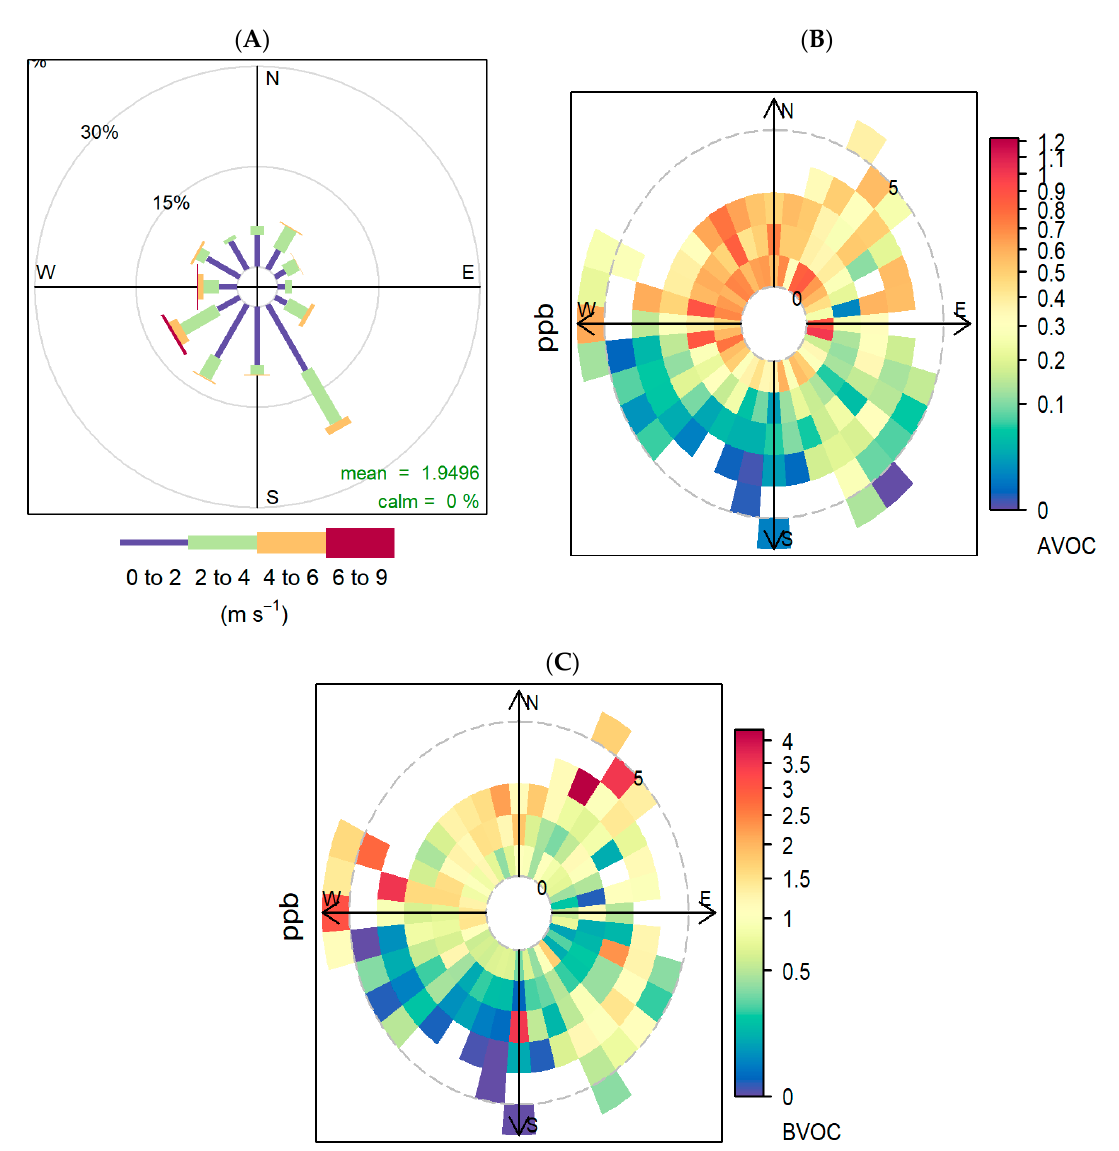
Figure 6. ( A ) Wind rose using wind observations at 10-m height for the entire sampling period. Predominance of the SW direction can be observed, with more than 35% of the observations coming from that quadrant, followed by SE winds with 25% of frequency. In addition, 85% of the time, the wind speed was lower than 3 m/s. ( B ) Polar plot using total mean concentrations of targeted AVOCs during COALA-JOEYS. ( C ) Polar plot using total mean concentrations of targeted BVOCs during COALA-JOEYS. Concentrations reported in